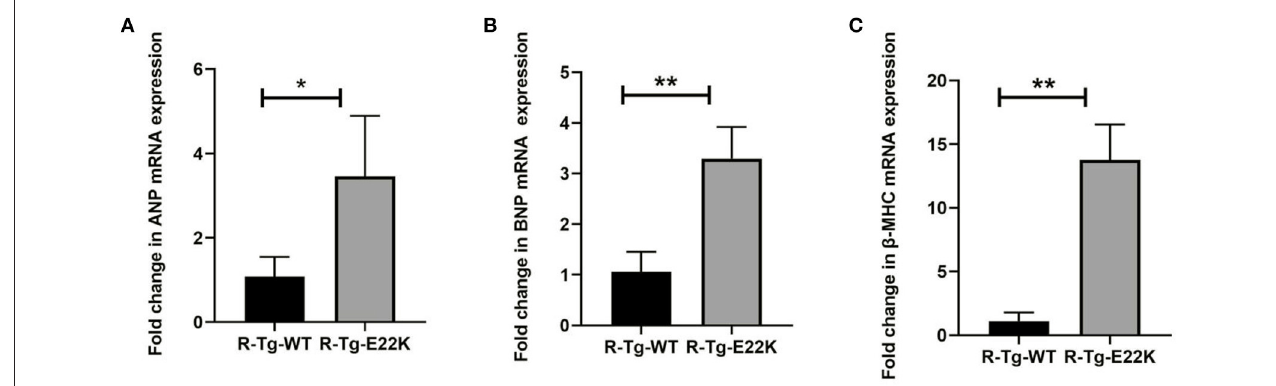
FIGURE 1 | E22K mutation significantly increases the expression levels of ventricular hypertrophy markers. (A–C) Real-time PCR analysis was conducted for the R-Tg-E22K and R-Tg-WT mice. The mRNA levels of ANP (A) , BNP (B) , and β -MHC (C) were determined using the delta-delta CT method. Compared to R-Tg-WT mice, the expression levels of these three genes were remarkably upregulated in R-Tg-E22K mice heart tissue. Each sample was repeated three times. Student’s t -test was employed to assess the differences in abundance levels. N = 3, * p < 0.05; ** p < 0.01. R-Tg-WT, wild-type transgenic mice in the rest group; R-Tg-E22K, transgenic E22K mice in the rest